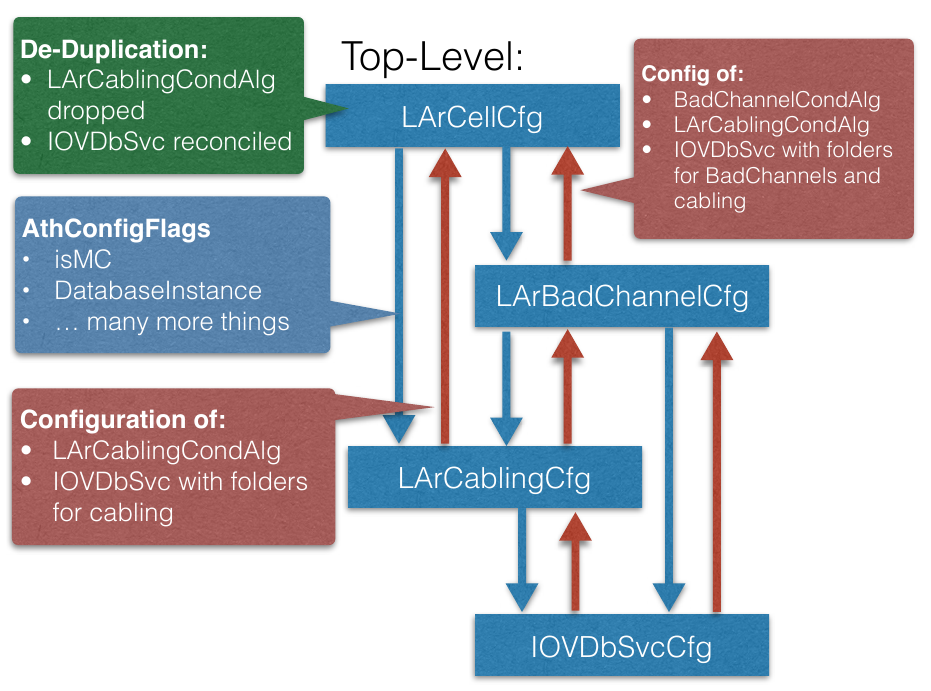
Figure 1. Example of a configuration work-flow. Blue arrows denote the container of flags passed down from caller to callee. Red arrows are instances of ComponentAccumulator returned by the configuration